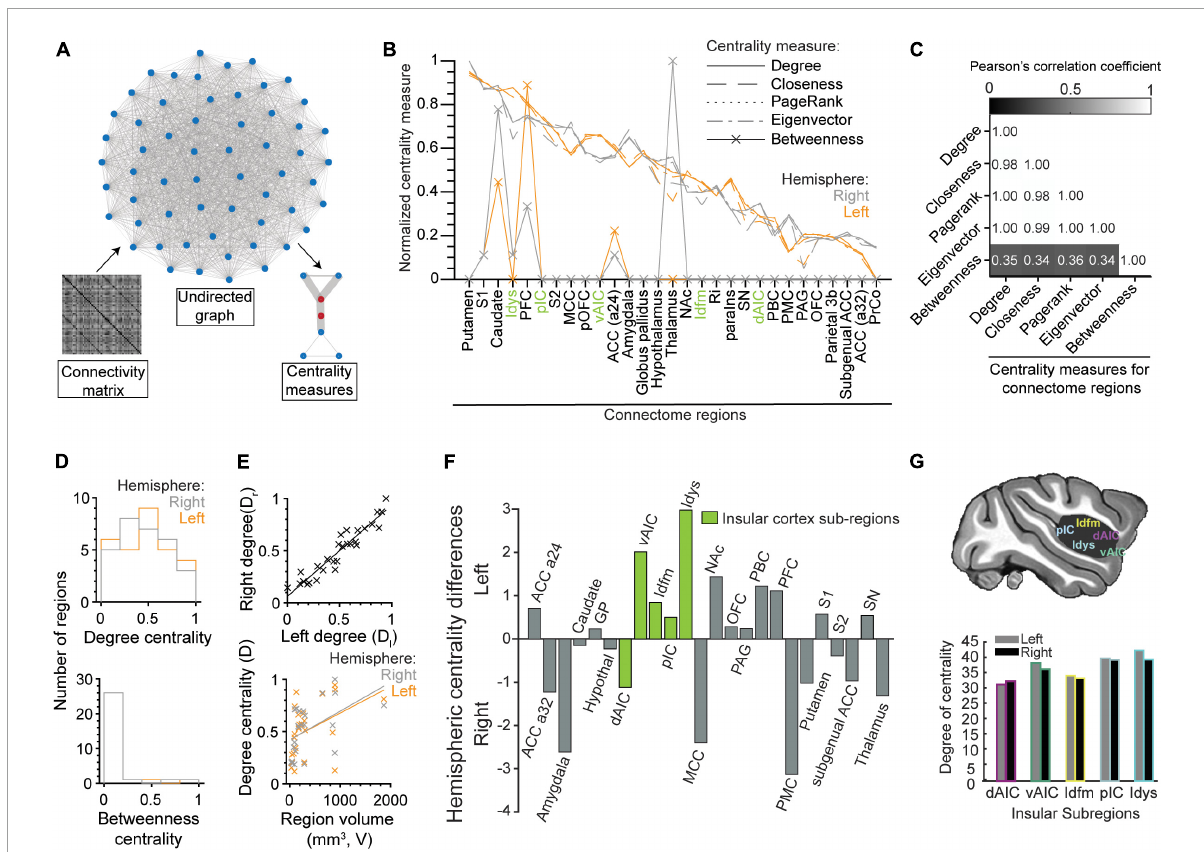
FIGURE7 Centrality measures of brain regions in the gustatory connectome. (A) Schematics demonstrating brain region centrality measurement from an undirected graph constructed from the respective connectivity matrix of β -series correlation. (B) Line plot of the normalized (to the [0, 1] interval) degree (solid line), closeness (dashed line), PageRank (dotted line), eigenvector (dot-dash line), and betweenness (line with crosses) centrality measures for the connectome regions in the left (orange, n = 29) and right (gray, n = 29) hemispheres. Note that centrality measures correlate well with the degree centrality with the exception of betweenness. (C) Matrix of the Pearson’s correlation coefficient between five centrality measures. Numbers indicate the value of correlation. (D) Histogram of the distribution of the normalized degree centrality (upper panel) and betweenness centrality (lower panel) for the right (gray) and left (orange) connectome nodes. Note that the betweenness centrality is zero for most regions. (E) Scatter plots showing the correlation between right and left hemisphere degree centrality (upper panel, r = 0.95, linear fit line: D r = 0.87 × D l + 0.06) and their relationship to the volume of the region (lower panel, left: r = 0.43, D l = 2.5 × 10 - 4 × V + 0.42, right: r = 0.49, D r = 2.8 × 10 - 4 × V + 0.42). (F) Bar plot for difference between left and right degree centrality of sub-regions in the insular (green) and other connectome regions (gray). Note that degree centrality is skewed to the left hemisphere for insular cortical regions ( p = 0.01, paired t -test of left vs. right degree centrality) and not the rest of the gustatory connectome ( p = 0.55, paired t -test). All insular cortex sub-regions, except the dorsal anterior fundus (dAIC), had nodes with greater centrality in the left hemisphere. (G) Schematic of the brain showing the five regions-of-interest in the insular cortex (upper panel). Bar plot of the degree centrality for insular sub-regions with the dysgranular insular (Idys) cortex exhibiting the greatest degree centrality and the dorsal anterior insular cortex (dAIC) exhibiting the least (lower